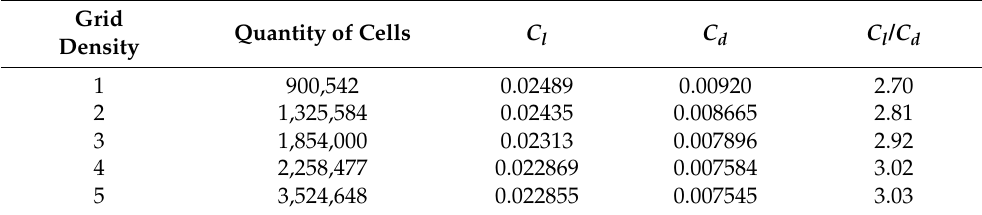
Table 7. Grid sensitivity results.